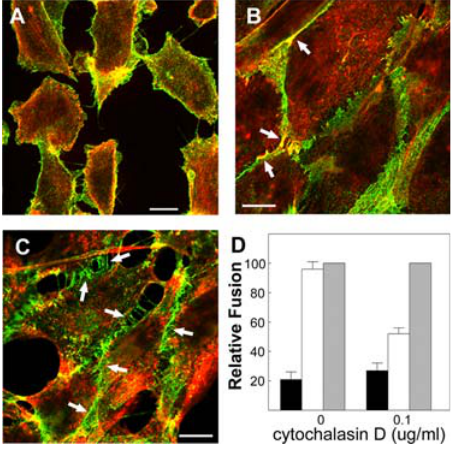
Figure 10. Efficient p14-mediated fusion requires active adhesion. Fluorescent images (panels A–C) of QM5 fibroblasts fixed and stained with anti-N-cadherin antibody (green) or fluorescently conjugated phalloidin (red). Scale bars=10 m m. (A) Cells cultured under low calcium conditions to disrupt cadherin-mediated cell–cell contacts and generate the no adhesion phenotype. (B) Cells cultured under low calcium conditions and then switched to normal calcium conditions to generate the active adhesion phenotype. (C) Cells cultured under low calcium conditions followed by treatment with cytoD under normal calcium conditions to allow cadherin engagement but not actin remodelling, generating the passive adhesion phenotype. Arrows in (B) indicate examples of F-actin and cadherin colocalization at sites of extended cell–cell contact. Arrows in panel (C) indicate sites of trans - cadherin interactions in the absence of extended junction formation. (D) QM5 cells were transfected with p14 and treated to generate the active, passive and no adhesion phenotypes depicted in the previous panels. Just prior to the onset of fusion (4 h post-transfection), cells were briefly subjected to calcium depletion (black and white bars) or maintained in normal calcium levels (grey bars). Immediately after depletion, cells were incubated in normal (white bars) or low calcium (black bars) medium in the presence or absence of cytoD as indicated. The extent of syncytium formation under the different culture conditions was quantified by syncytial indexing 2–4 h after the return to normal calcium containing media. Data is presented as the extent of fusion relative to cells maintained throughout the experiment in normal calcium medium with or without cytoD. Values represent the mean 6 S.E. (n=5). The average numbers of syncytial nuclei per field under normal calcium levels (i.e. the 100% level) were 68.9 (no cytochalasin treatment) and 46.9 (with cytochalasin treatment).